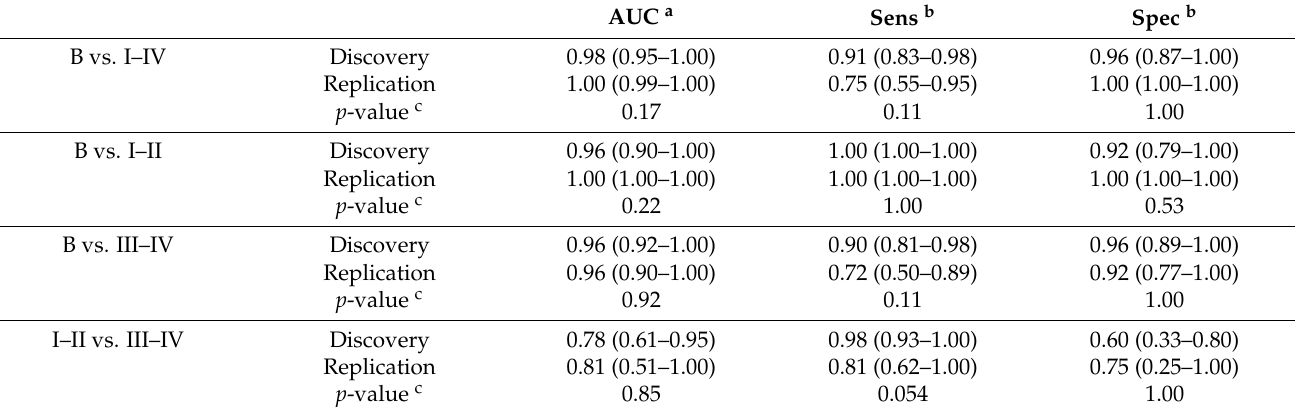
Table 2. Results of multivariate modelling based on proteins with nominal univariate